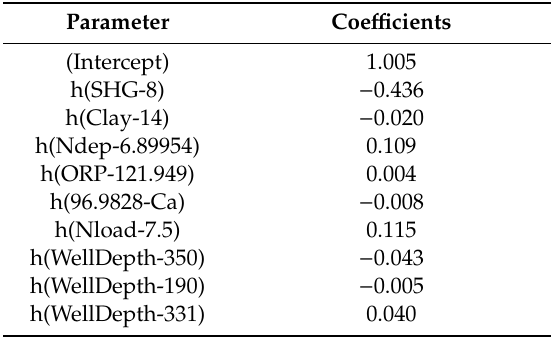
Table 3. Model Coe ffi cients of the MARS Model along with the Cut-O ff Table 3. Model Coefficients of the MARS Model along with the Cut-Offs.